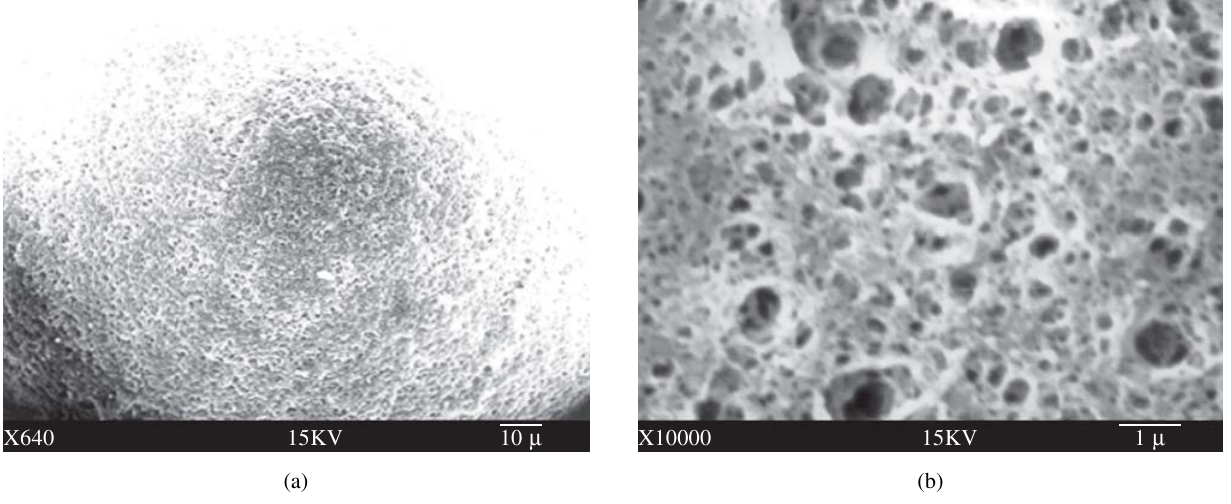
Figure 2. SEM micrograph of HEMA/MMA (1:1) and 10% EDMA copolymerized beads with 35% addition of porogen solvent, DOD, before (a, 640 ×, scale bar 10 µ m) and after (b, 10.000 ×, scale bar 1 µ m) Soxhlet extraction.